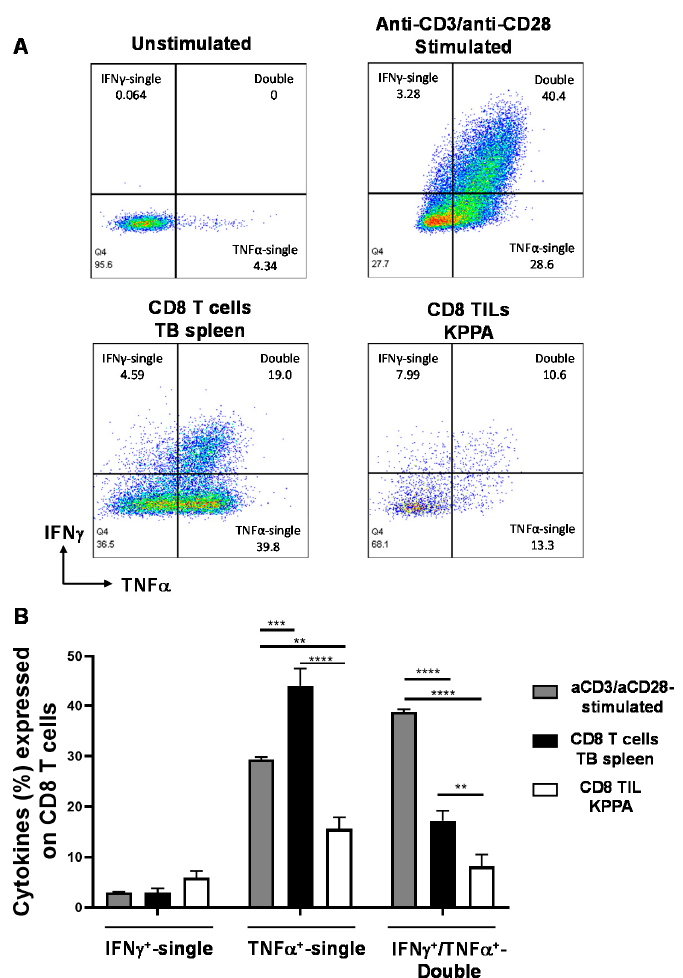
Figure 5. Reduced polyfunctionality of CD8 tumor-infiltrating lymphocytes (TILs) in KPPA tumors. ( A ) Representative flow plots of the CD8 T cells producing either single or double cytokines (IFN γ + -single, TNF α + -single, and IFN γ + TNF α + -double); ( B ) Quantification of the percentage of IFN γ + -single, TNF α + -single, and IFN γ + TNF α + -double in CD8 T cells of indicated groups. Intracellular cytokine staining was performed for the following groups: anti-CD3 / anti-CD28 stimulated T cells ( n = 6), CD8 T cells from TB spleen ( n = 14) or CD8 TILs from KPPA tumors ( n = 18). No statistical di ff erence was observed when comparing IFN γ + -single production in CD8 T cells between anti-CD3 / anti-CD28 stimulated (3.02 ± 0.14), the TB spleen (2.97 ± 0.84) and KPPA tumors (5.91 ± 1.32). Both groups of KPPA tumors (15.63 ± 2.26, p < 0.0001) and anti-CD3 / anti-CD28 stimulated (29.33 ± 0.51, p = 0.0008) produced significantly lower levels of TNF α + -single than TB spleen group (43.92 ± 3.45). CD8 TILs from KPPA tumors (8.12 ± 2.36) produced significantly lower levels of IFN γ + TNF α + -double than TB spleen (17.22 ± 1.98, p = 0.0086) or anti-CD3/anti-CD28 stimulated (38.75 ± 0.55, p < 0.0001). Percentages of cells were compared by two-way ANOVA with Tukey’s multiple-comparison test correction. ** p < 0.01, *** p < 0.001, **** p < 0.0001.